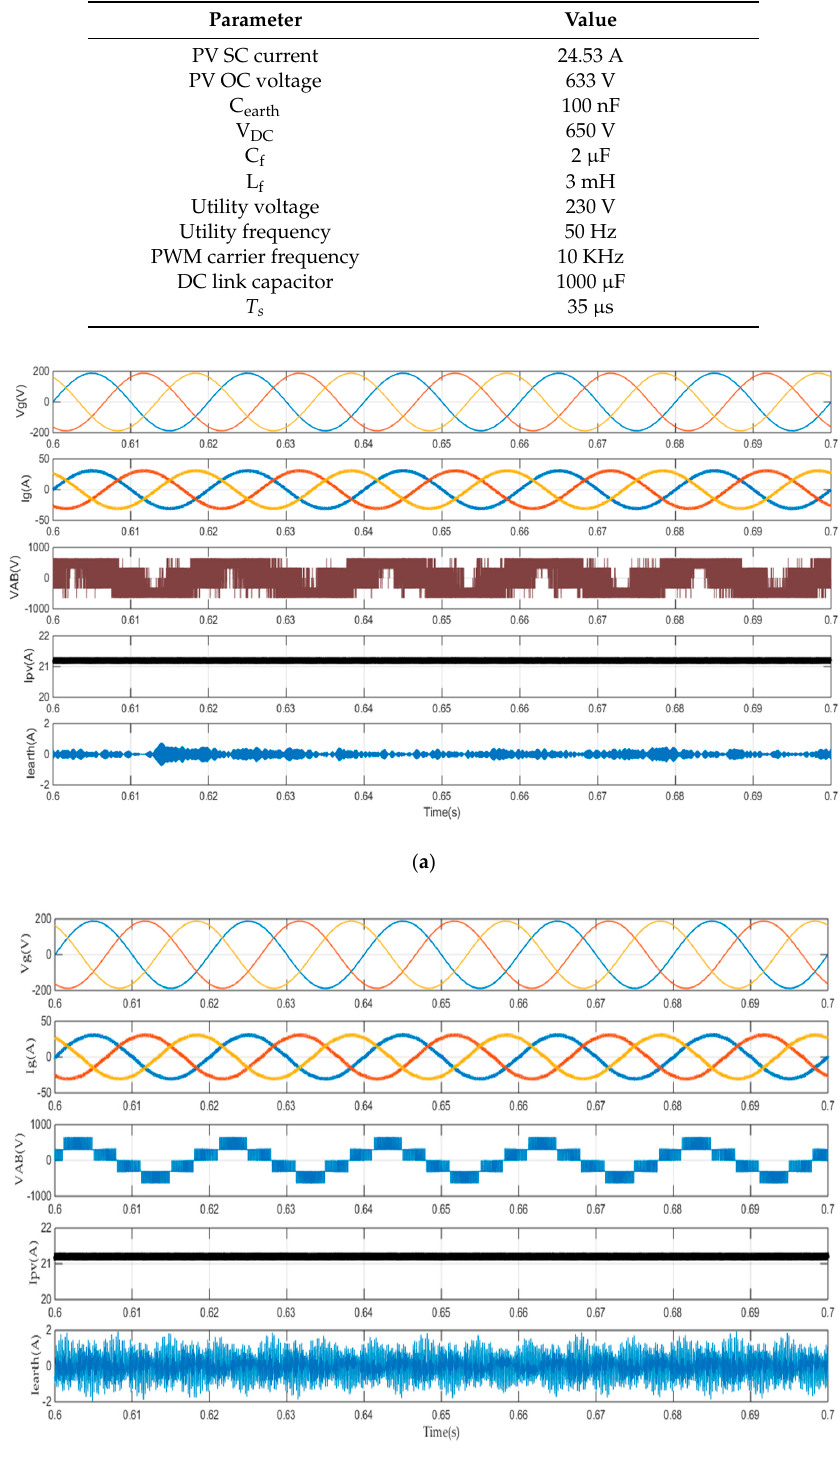
Figure 8. Simulation results of the proposed neutral-point-clamped (NPC) transformerless inverter in terms of grid voltage, grid current, PV current, and earth leakage current with ( a ) the MPC controller and ( b ) the proportional–integral (PI) current controller with sinusoidal pulse width modulation (SPWM).